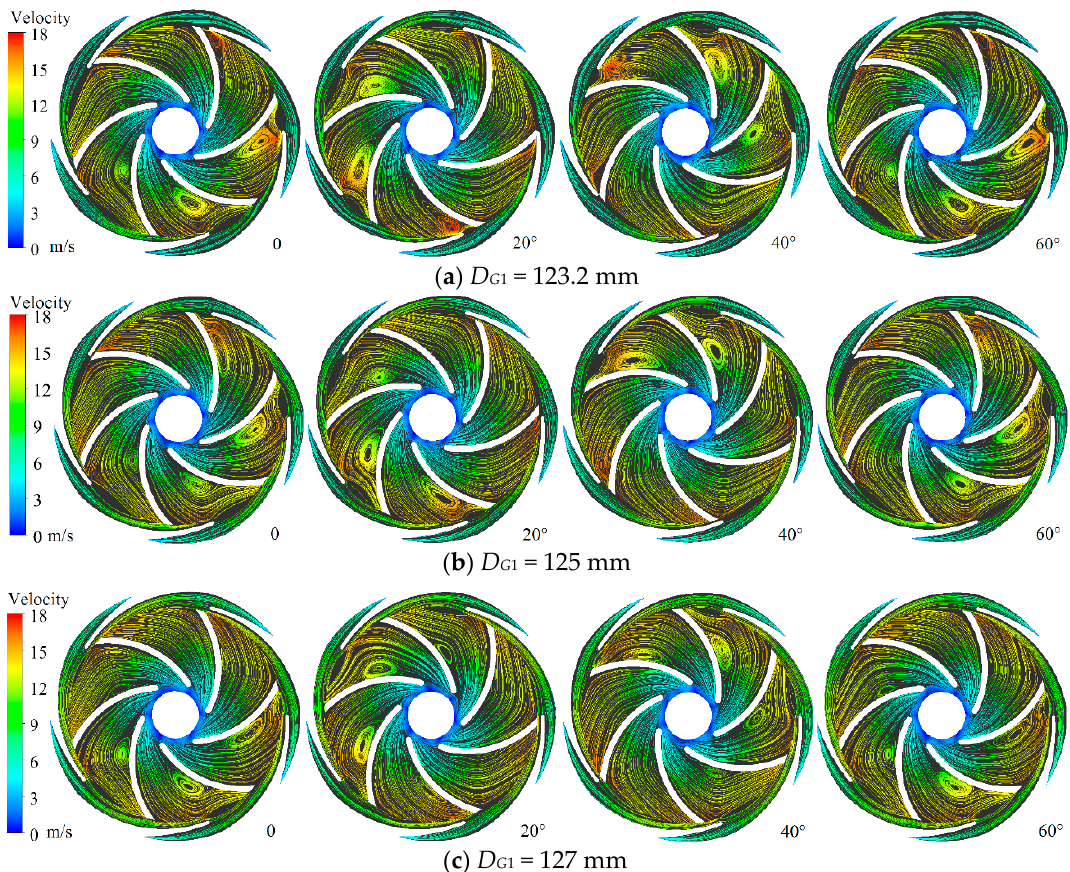
Figure 25. Evolution processes of the transient flow field inside the impeller and guide vane with different inlet diameters of the positive guide vane.